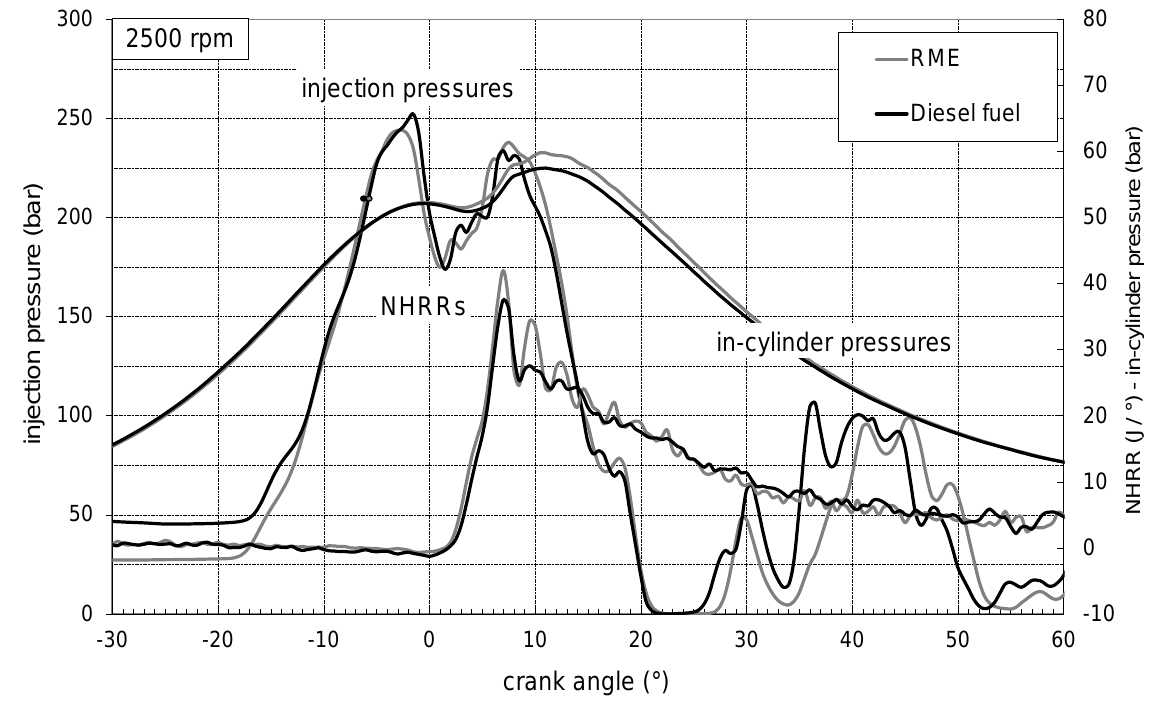
Figure 8. RME and diesel fuel injection pressures, in-cylinder pressures, and NHRR at 2250 rpm and at full load.